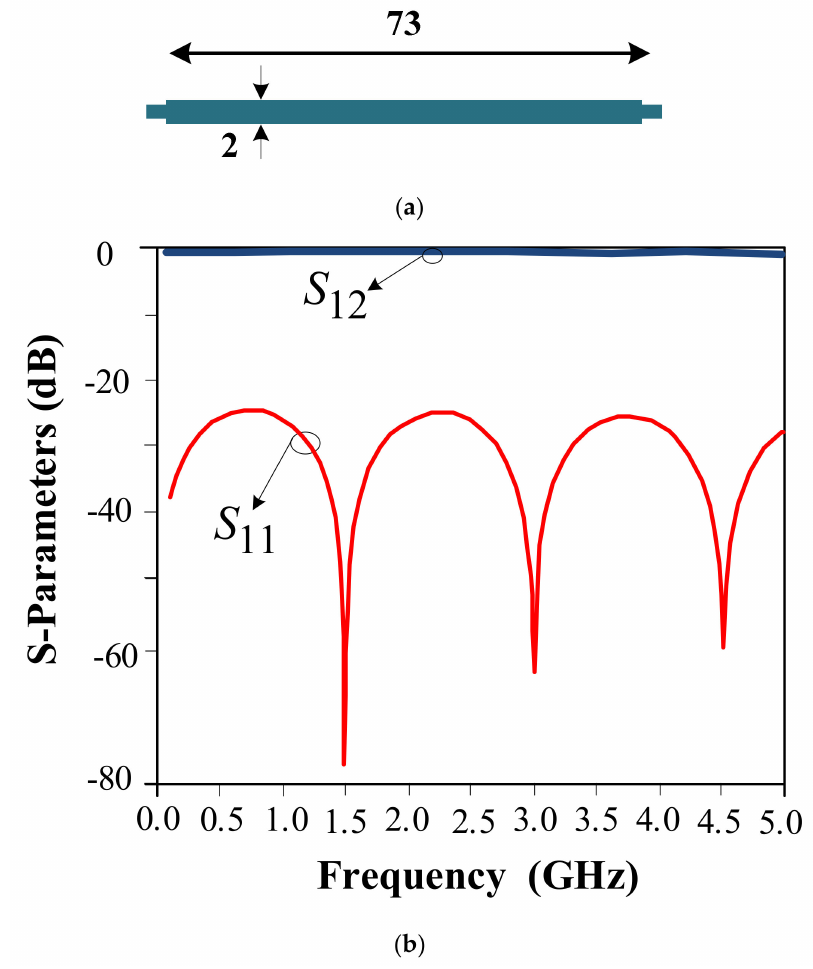
Figure 4. Horizontal λ /4 branch of 35 Ω impedance at 750 MHz; ( a ) layout with dimensions in millimeters and ( b ) the simulation of the S 11 and S 12 magnitudes in